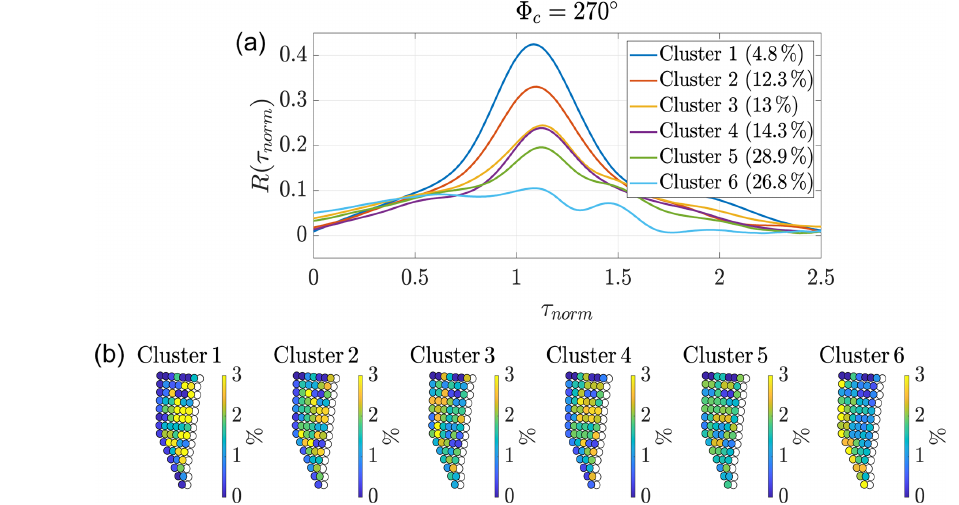
Figure C2. Clustering for wind direction interval around 270 ◦ with randomly sorted parameters and k = 6. (cid:56) c depicts the centre of the wind direction